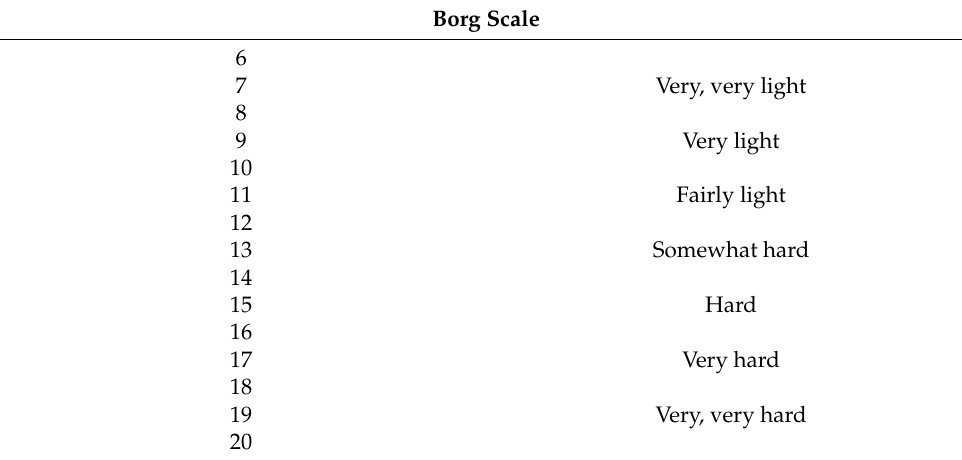
Table 2. The Borg scale: a subjective evaluation of the degree of